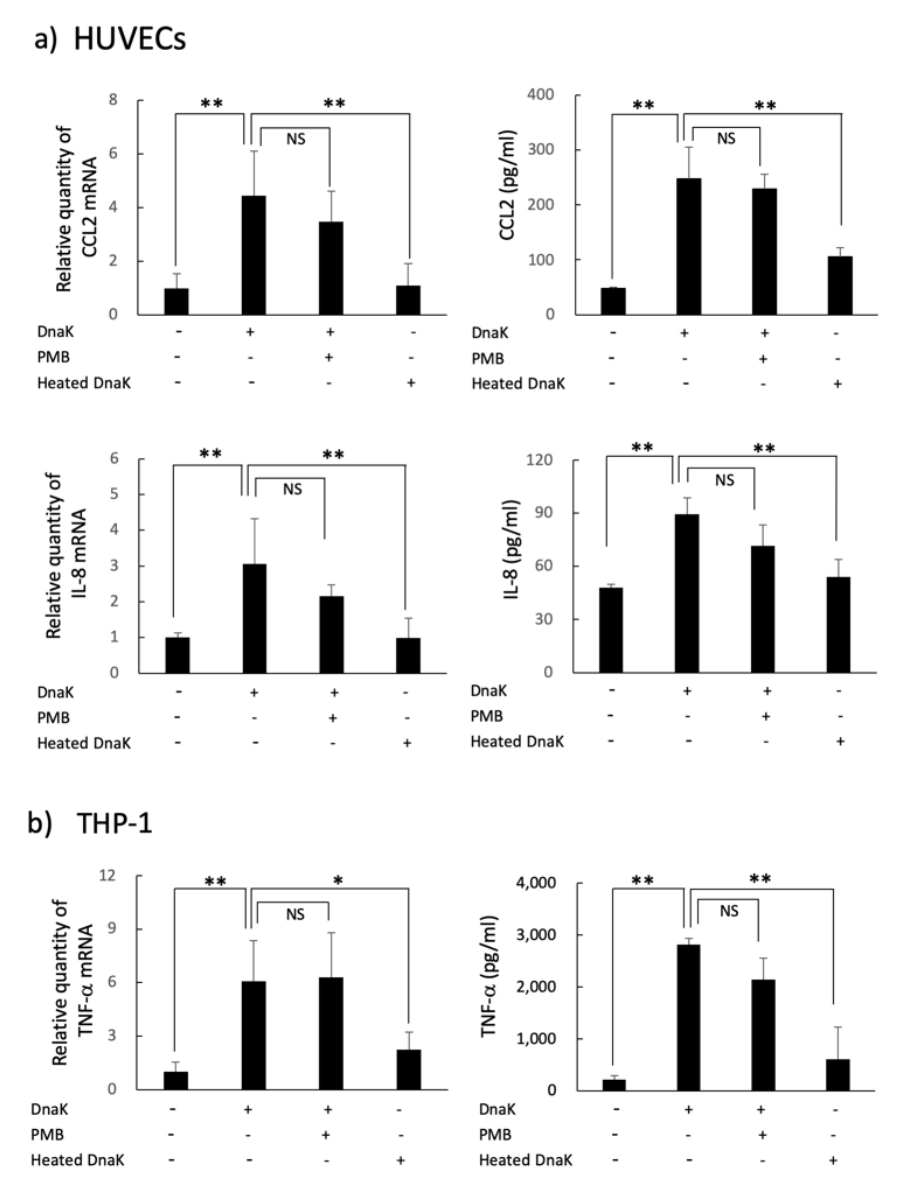
Figure 4. Induction of cytokines in HUVECs or THP-1 cells stimulated with A. defectiva rDnaK. A. defectiva rDnaK was added to the wells of a 24-well micro-plate with a semiconfluent culture of HUVECs ( a ) or THP-1 cells ( b ) at a dose of 2 µ g/mL. After incubation for 1 or 4 h at 37 ◦ C, total RNAs were extracted and the complementary DNA was synthesized from total RNAs. Quantitative real-time RT-PCR analysis was conducted using the primers for TNF- α , IL-8, CCL2, and GAPDH. The contents of TNF- α , IL-8, and CCL2 in culture supernatants were measured using ELISA kits. In some experiments, DnaK either treated with 10 µ g/mL of PMB for 1 h or heated for 15 min at 100 ◦ C was used. Data are expressed as the mean ± SD from three independent experiments, each performed in duplicates. Six samples were analyzed in each group. Statistically significant differences; NS, not significant, * p < 0.05, ** p <